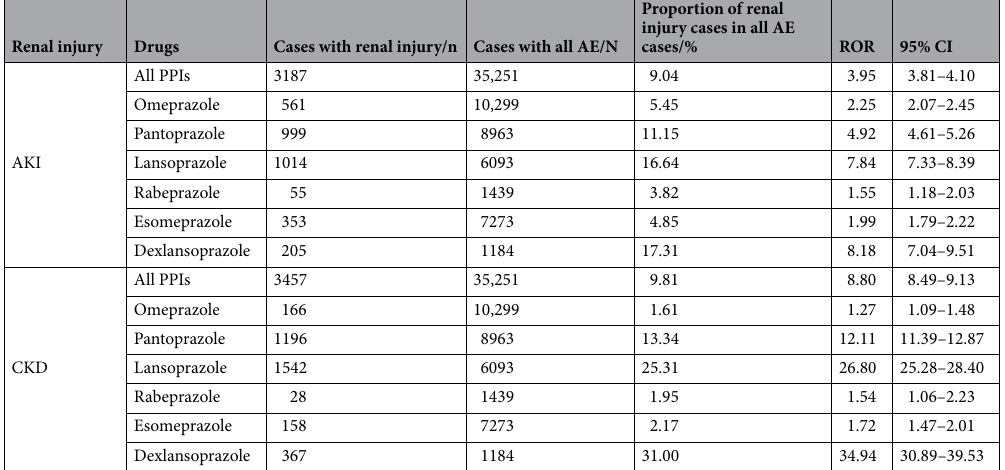
Table 2. Signal detection for AKI and CKD of PPIs users from FAERS database. PPIs proton pump inhibitors, AKI acute kidney injury, CKD chronic kidney disease, AE adverse event, ROR reporting odds ratio, 95% CI 95% confidence interval.